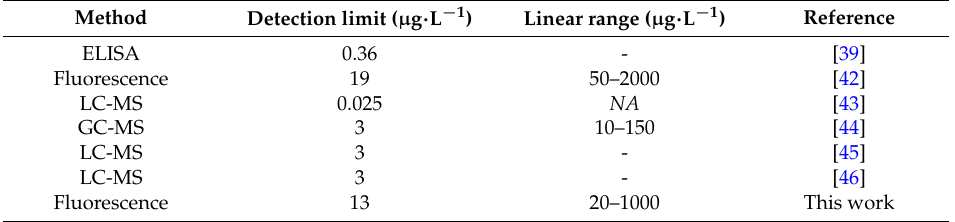
Table 3. Comparison of the developed UCNPs-involved MIP method with the previously-reported methods for ST determination.